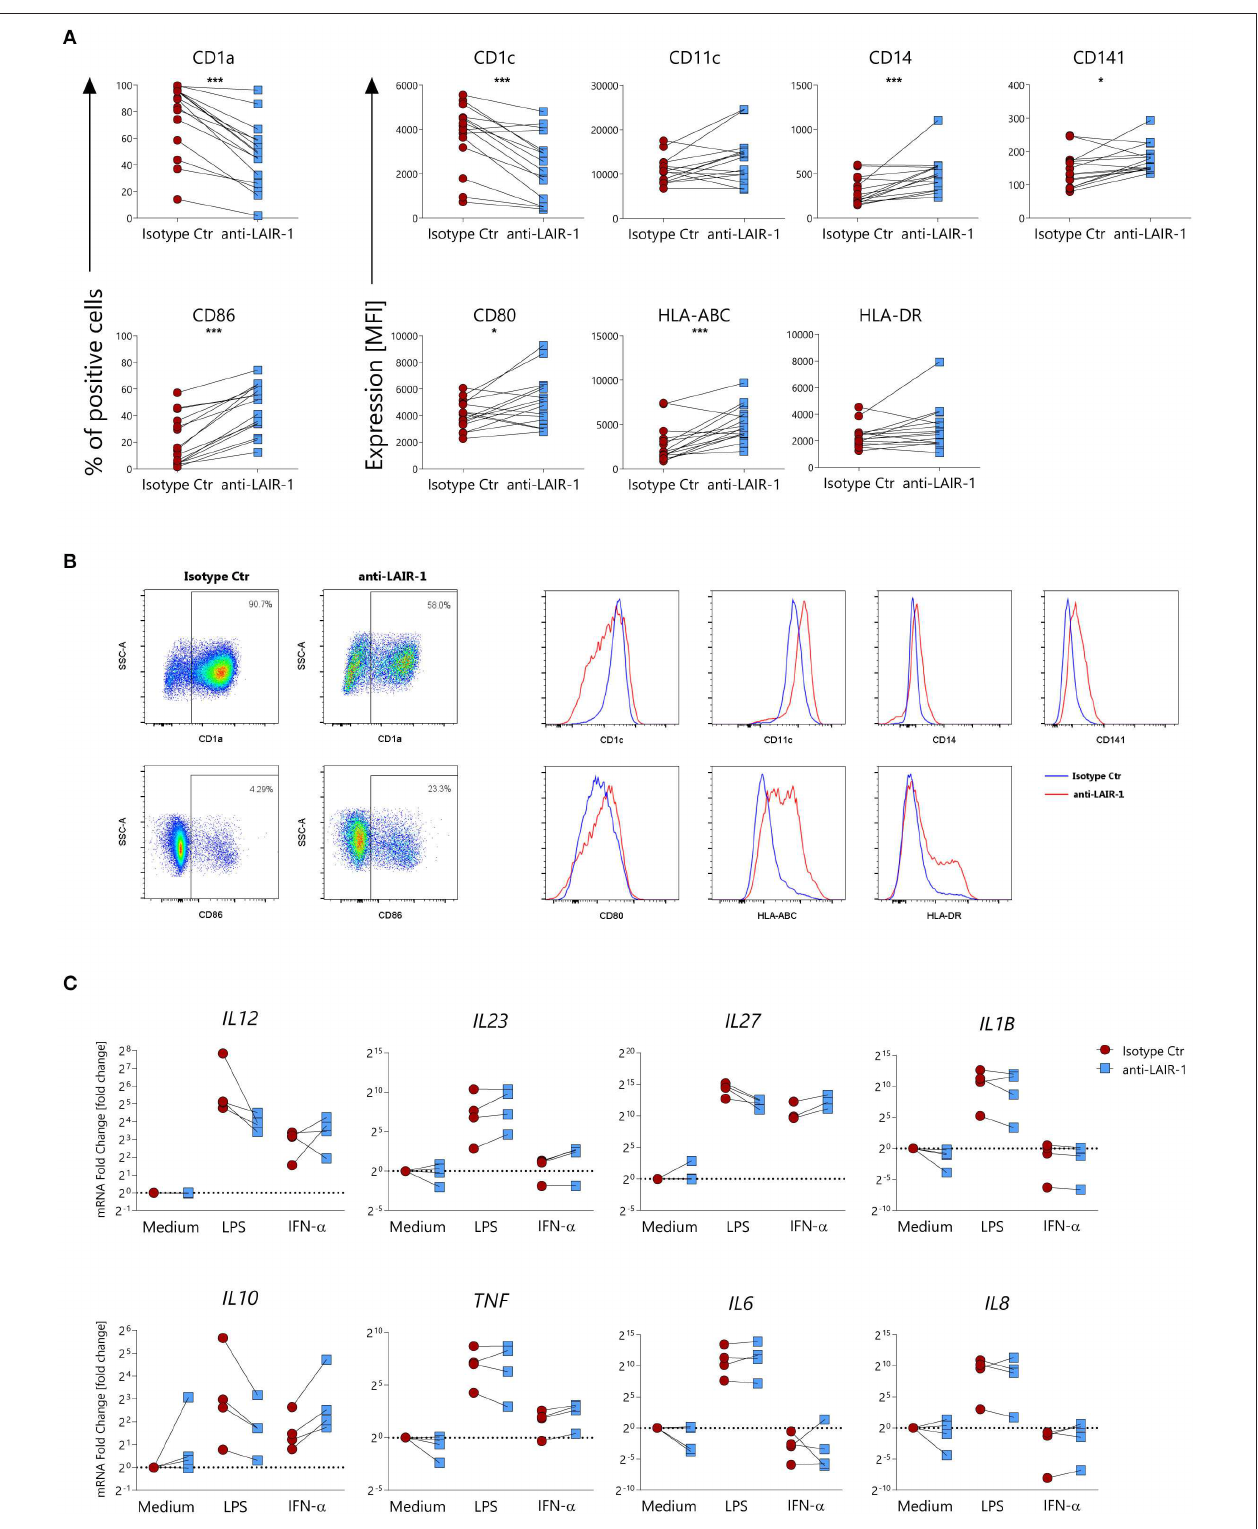
FIGURE 5 | LAIR-1 activation during differentiation of monocyte-derived dendritic cells results in phenotypic and cytokine profile alterations. (A) Purified monocytes were differentiated for 6 days into monocyte-derived dendritic cells using GM-CSF and IL-4 in the presence of anti-LAIR-1 agonist (Dx26) or isotype control and the